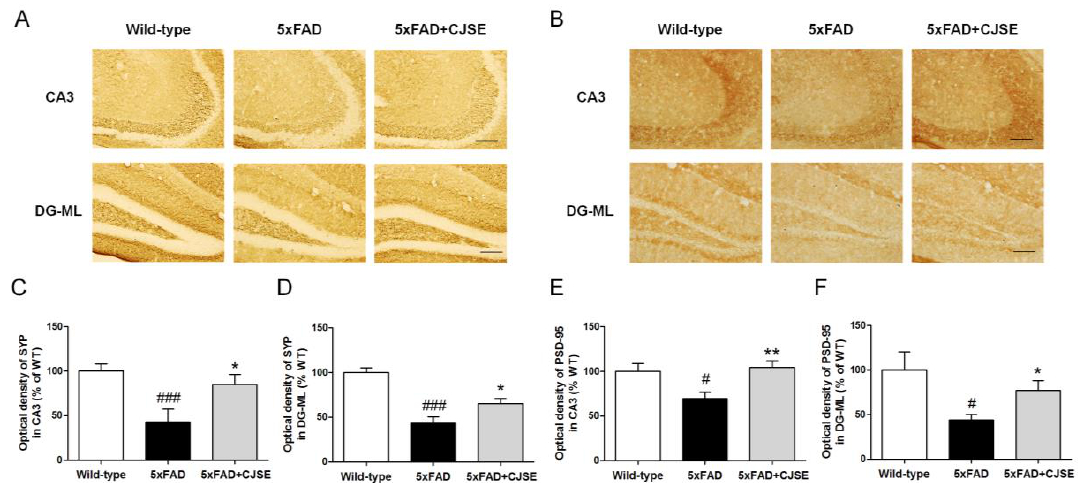
Figure 2. E ff ects of CJSE on synaptic loss in 5xFAD mice. ( A , B ) Representative photomicrographs of synaptophysin (SYP) ( A ) and post-synaptic density protein 95 (PSD-95) ( B ) immunoreactive regions in hippocampal CA3 and DG-ML; scale bar = 100 µ m. ( C , D ) Quantifications of SYP immunoreactive regions in hippocampal CA3 ( C ) and DG-ML ( D ). ( E , F ) Quantifications of PSD-95 immunoreactive regions in hippocampal CA3 ( E ) and DG-ML ( F ). Values are indicated as the mean ± S.E.M. # p < 0.05 and ### p < 0.001 compared to wild-type mice; * p < 0.05 and ** p < 0.01 compared to 5xFAD mice. CA3; cornu ammonis 3, DG-ML; molecular layer of the dentate gyrus.